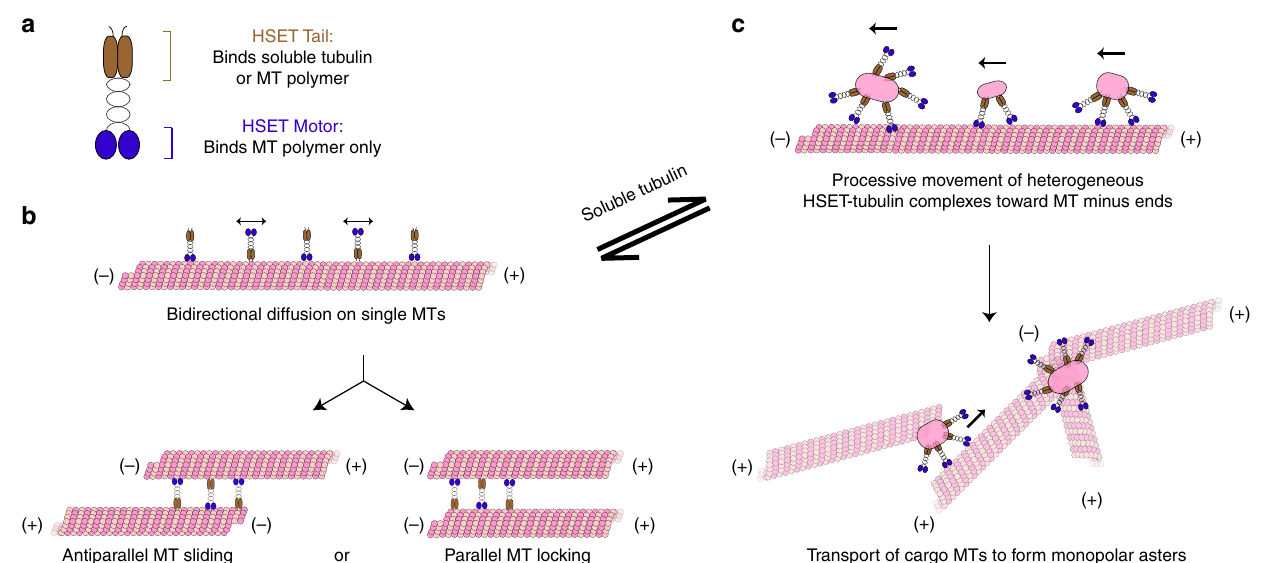
Fig. 7 Proposed model for MT aster formation by HSET. a HSET ’ s N-terminal tail domain is able to bind either soluble (non-MT) tubulin or MT polymer (brown), whereas HSET ’ s C-terminal motor domain is only able to bind MT polymer (blue). The relative availability of soluble tubulin toggles HSET ’ s activity between the following states: b HSET is unbound to soluble (non-MT) tubulin and exists as a dimer. This motor is: (i) nonprocessive on single MTs, and (ii) provides MT – MT sliding forces within bundles of MTs similar to established models for Ncd. c HSET is bound to soluble (non-MT) tubulin and exists in heterogeneous multimotor HSET-tubulin clusters. The precise molecular and geometrical nature of these clusters remain to be determined. These motors: (i) move processively toward the minus ends of single MTs, and (ii) processively transport MTs or MT bundles along existing MT tracks to form MT asters. This ability to toggle between modes relies on the unique ability of the N-terminal tail domain to bind both soluble (non-MT) tubulin and